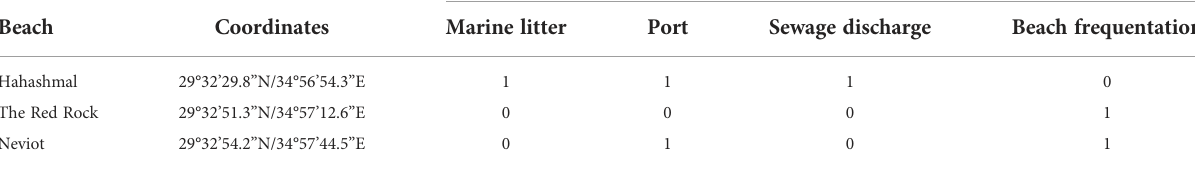
TABLE 1 Characteristics of the sampling sites considered in this study.